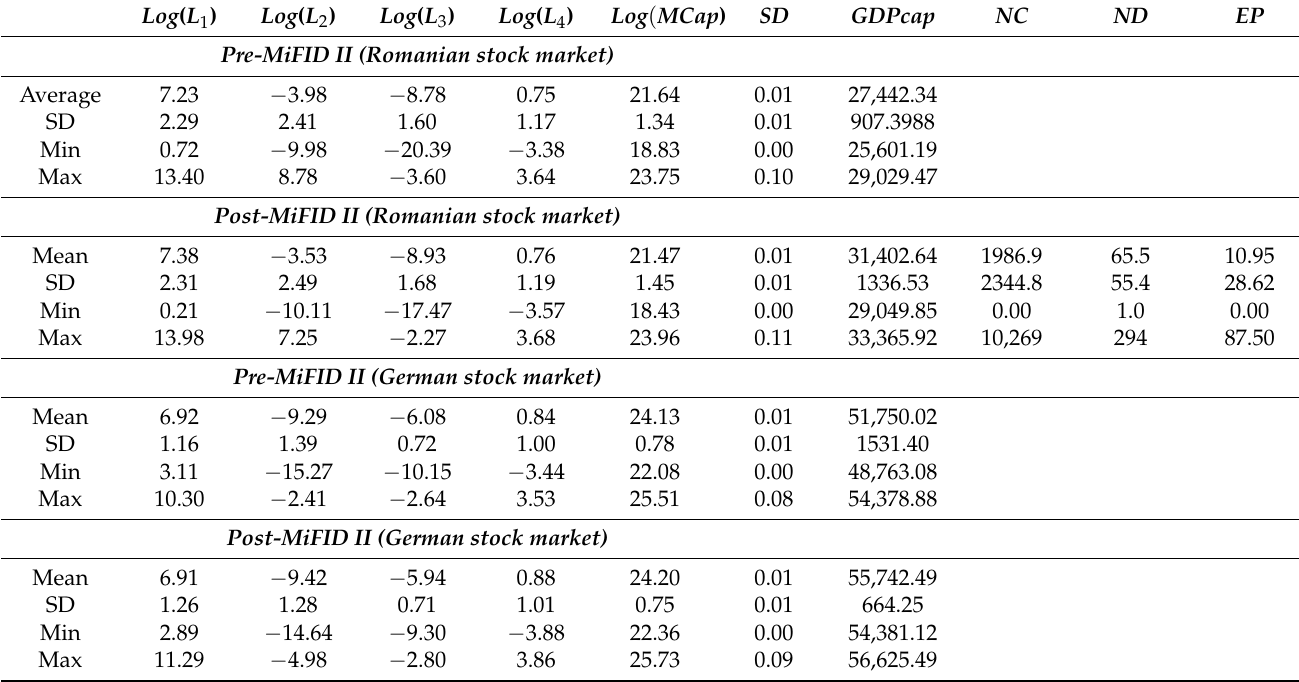
Table 1. Descriptive statistics (2-year